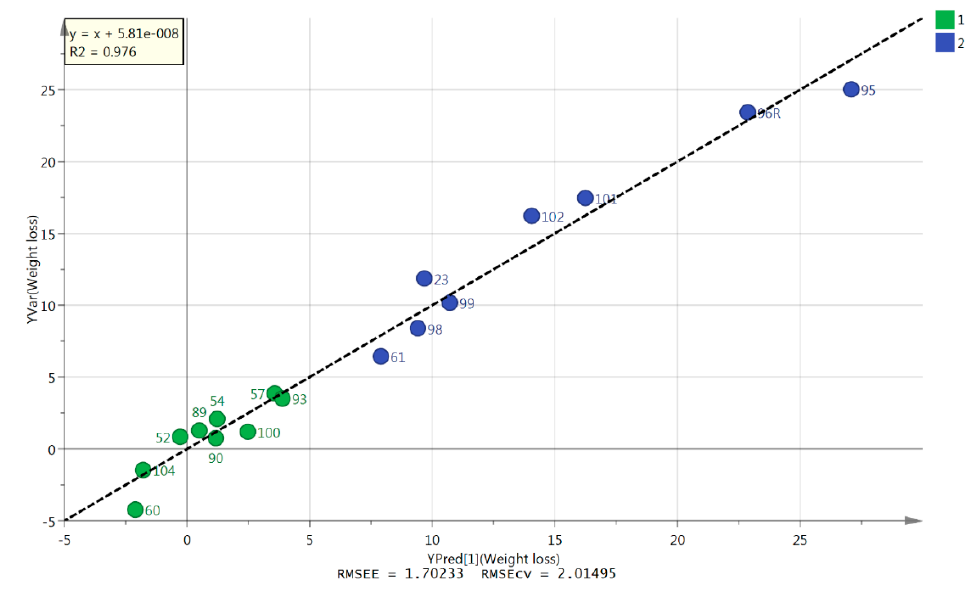
Figure 1. Orthogonal partial least squares (OPLS) model. OPLS model showing close correlation for eight ≥ 5% WL samples and nine WS samples between predicted and actual weight change (CVANOVA = 0.0014) based on six variables listed in Table 2. Green circles (group 1) = WS, blue circles (group 2) = ≥ 5% WL. Table 3. Significant metabolites that differ between ≥ 5% WL and WS groups ( n = 9 and 9 respectively).